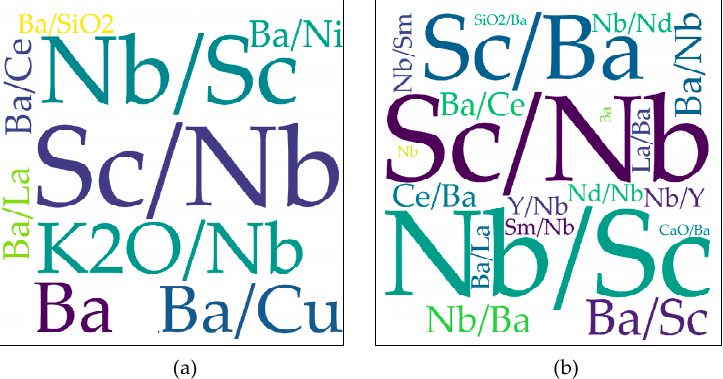
Figure 20. IAG–OIG–MORG discrimination diagrams. All four diagrams have a 0.85 confidence region. ( a , b ) are in linear coordinates; ( c , d ) are in logarithmic coordinates.